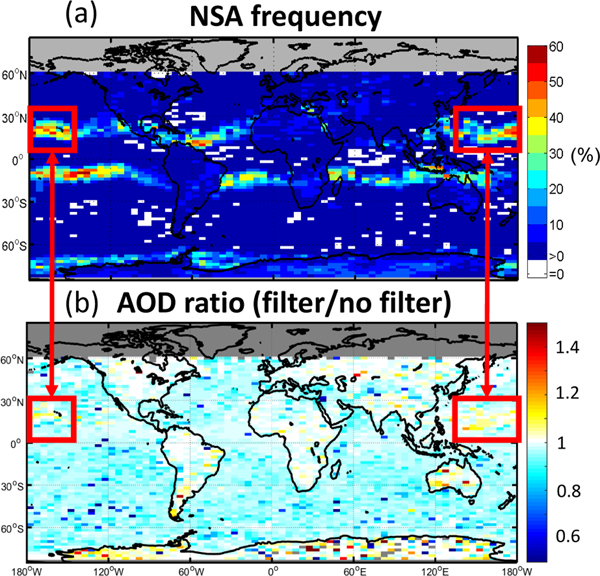
(a) Frequency of level 1B profiles containing the negative signal anomaly (NSA) in parallel 532 nm lidar channel and (b) ratio of level 3 mean AOD with and without NSA mitigation filter for July 2008 at night. Note that the geographic location of enhanced NSA frequency changes seasonally.